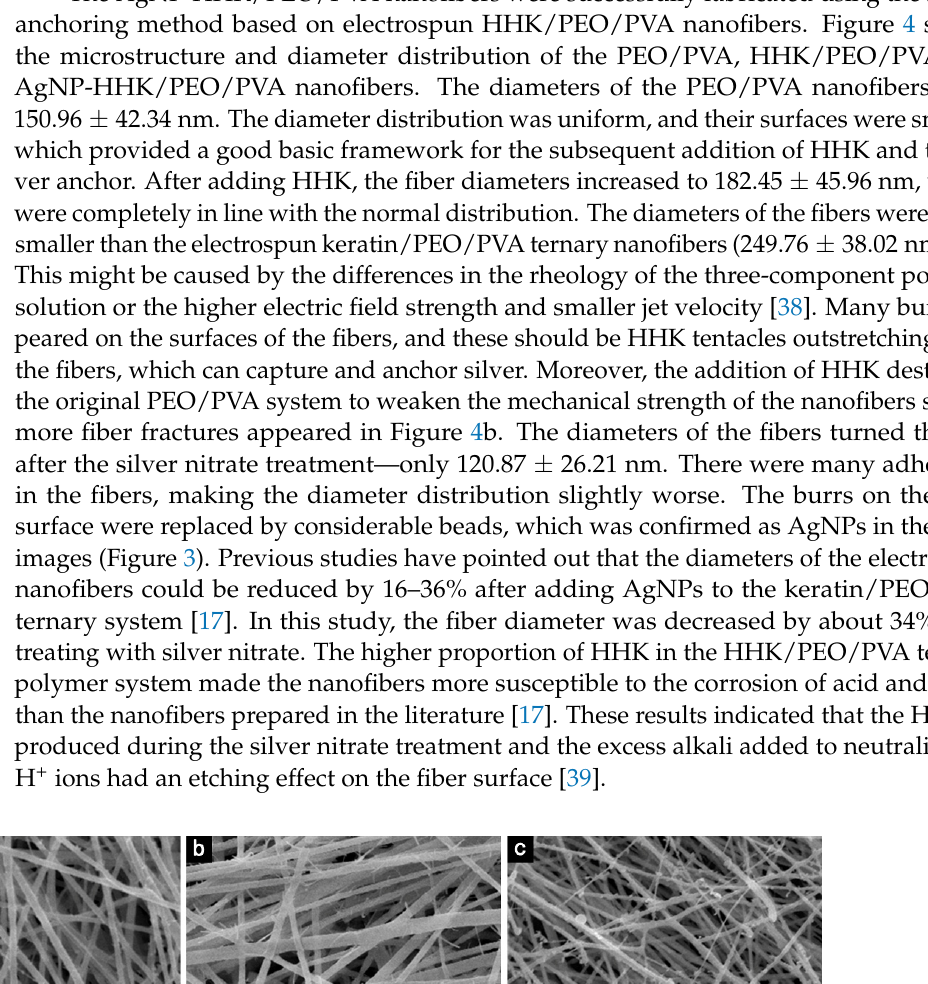
HHK/PEO/PVA and AgNP-anchored HHK/PEO/PVA nanofibers. The spectra of the HHK extract showed the characteristic absorption bands of peptides, which was clear ev- idence of the presence of kerateine. The vibrations of the peptide bonds could be at- tributed to amide A, amide I, amide II and amide III [19]. The broad absorption band at 3279 cm − 1 was generally associated with amide A and the stretching vibrations of the N- H bond. The amide I bands (the stretching vibrations of C=O) and amide II bands (the bending vibrations of N-H) were observed at 1637 and 1517 cm − 1 , respectively. Addition- ally, the absorption bands at 1238 and 1389 cm − 1 belonged to the amide III vibrations, demonstrating the presence of α -helical structure [40]. In the case of the neat PEO/PVA nanofibers, the broad absorption band at 3303 cm − 1 was assigned as the O-H stretching of PVA. Additionally, the absorption peaks at 842 and 1467 cm − 1 referred to the O-H and C=O bending vibrations of PVA. A double peak at 2882 and 2860 cm − 1 represented the stretching vibrations of CH 2 [41]. The sharp peak at 1096 cm − 1 was produced by C-O-C stretching [42]. The functional group profile showed bending vibrations at 962 and 1341 cm –1 , also representing C-H stretching. The incorporation of HHK into the PEO/PVA nan- ofibers indicated characteristic peaks of amide bonds (the red line of Figure 5), which con- firmed that HHK/PVA/PEO nanofibers had been successfully electrospun. The in situ sil- ver nanoparticles deposited on the fiber surface reduced the infrared peak intensity of PEO/PVA and retained the characteristic peaks of HHK. It was illustrated that the silver nanoparticles restricted the vibration of bonds in PEO and PVA, which had an impact on the intermolecular structure. However, all the hydrogen bonds in the α -helix of HHK were intramolecular hydrogen bonds, and they pointed to the same direction along the helix axis, resulting in a stable configuration. The thiol groups of the cysteine residues in HHK interacted with silver ions to form silver thiolate nanoclusters (AgNPs, Figure 3), which would not cause changes in the HHK structure [43].